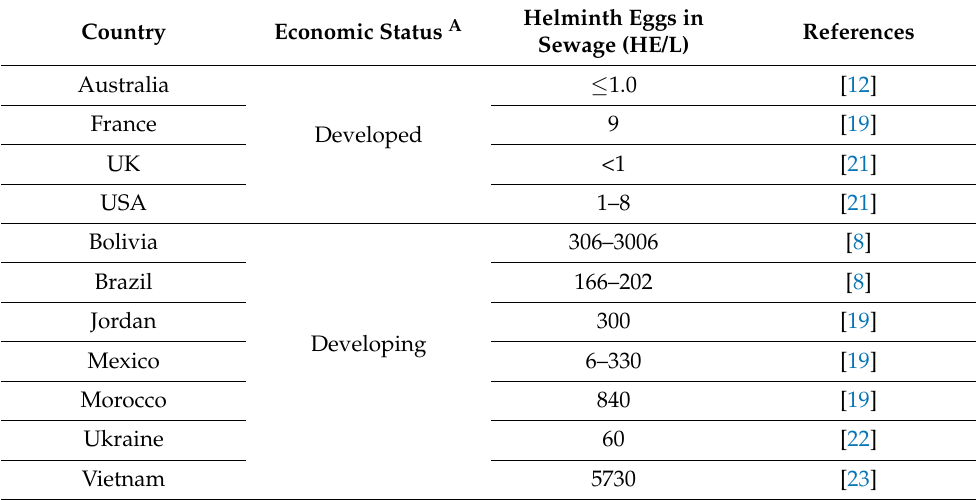
Table 1. Reported concentrations of helminth eggs of human health significance in sewage from developing and developed